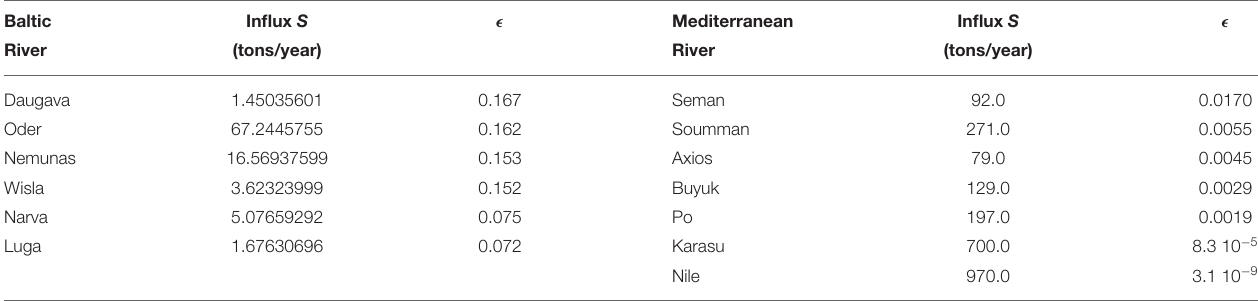
TABLE 1 | ǫ for major rivers supplying the Baltic and Mediterranean Sea with fresh water and macro plastic pollution; rows for each region sorted according to ǫ , generated with P † = 1 for comparison.